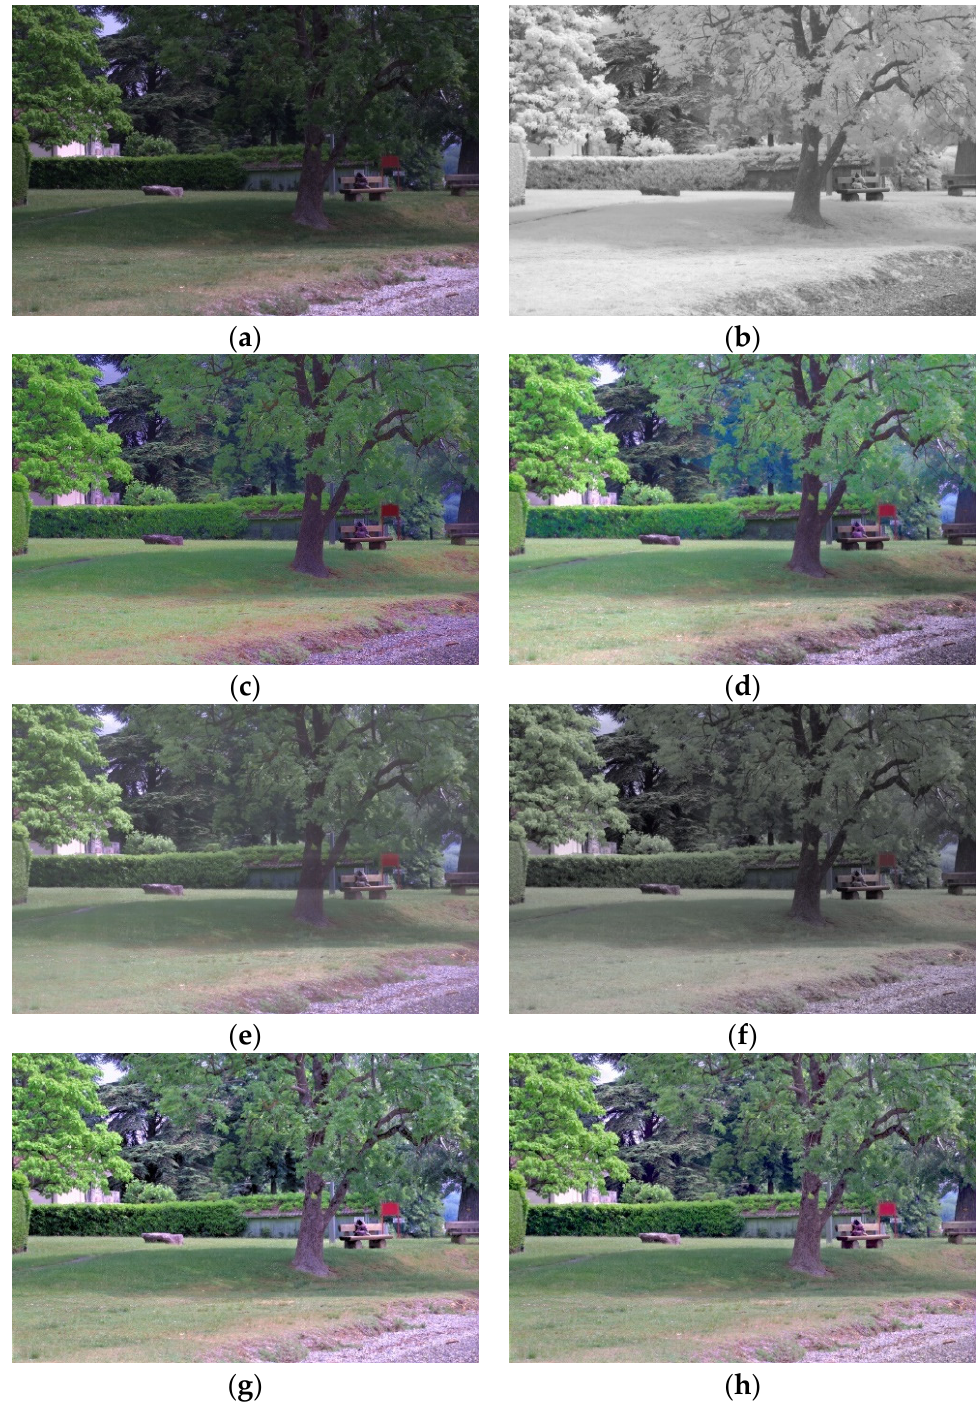
Figure 13. Input pair images and result images: ( a ) Visible image, ( b ) IR image, ( c ) Laplacian pyramid entropy fusion, ( d ) Laplacian pyramid PCA fusion, ( e ) Low rank fusion, ( f ) dense fusion, ( g ) Proposed method (Luminance channel fusion), ( h ) Proposed method (XYZ channel fusion).